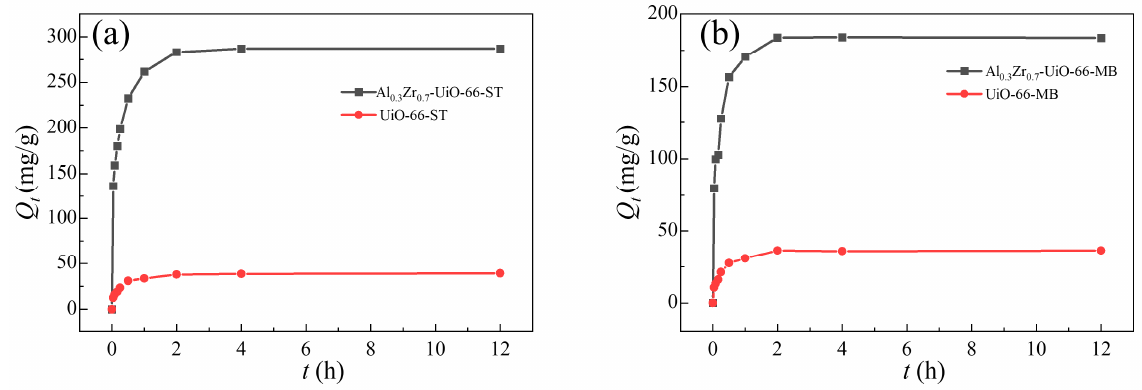
Figure 7. Adsorption kinetics of ( a ) ST and ( b ) MB in UiO-66 and Al 0.3 Zr 0.7 -UiO-66.